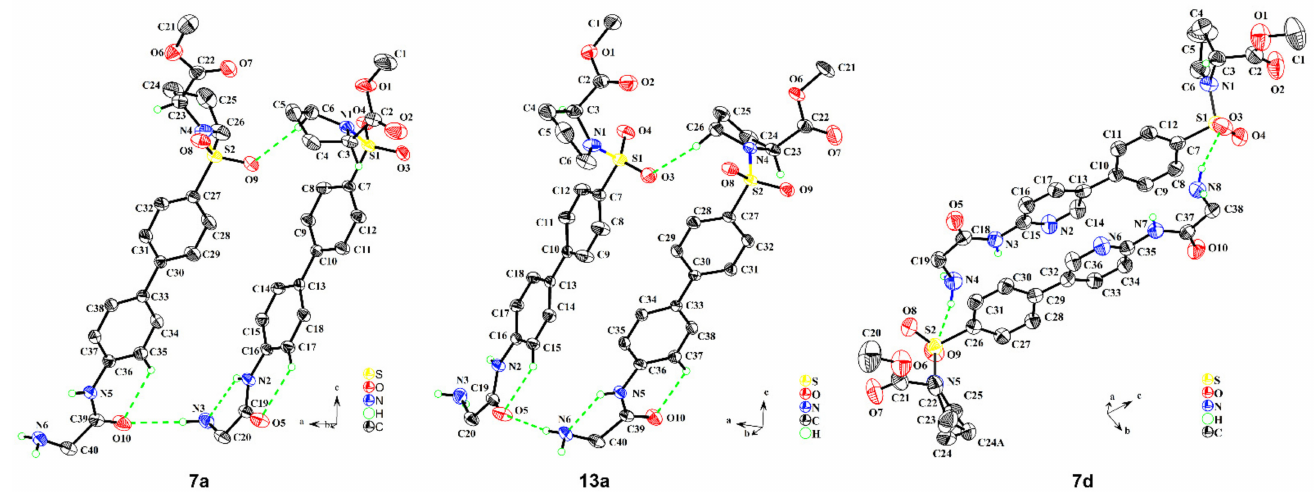
Figure 5. A perspective view of 7a , 7d , and 13a , showing the atom-labelling scheme. Displacement ellipsoids are drawn at the 50% probability